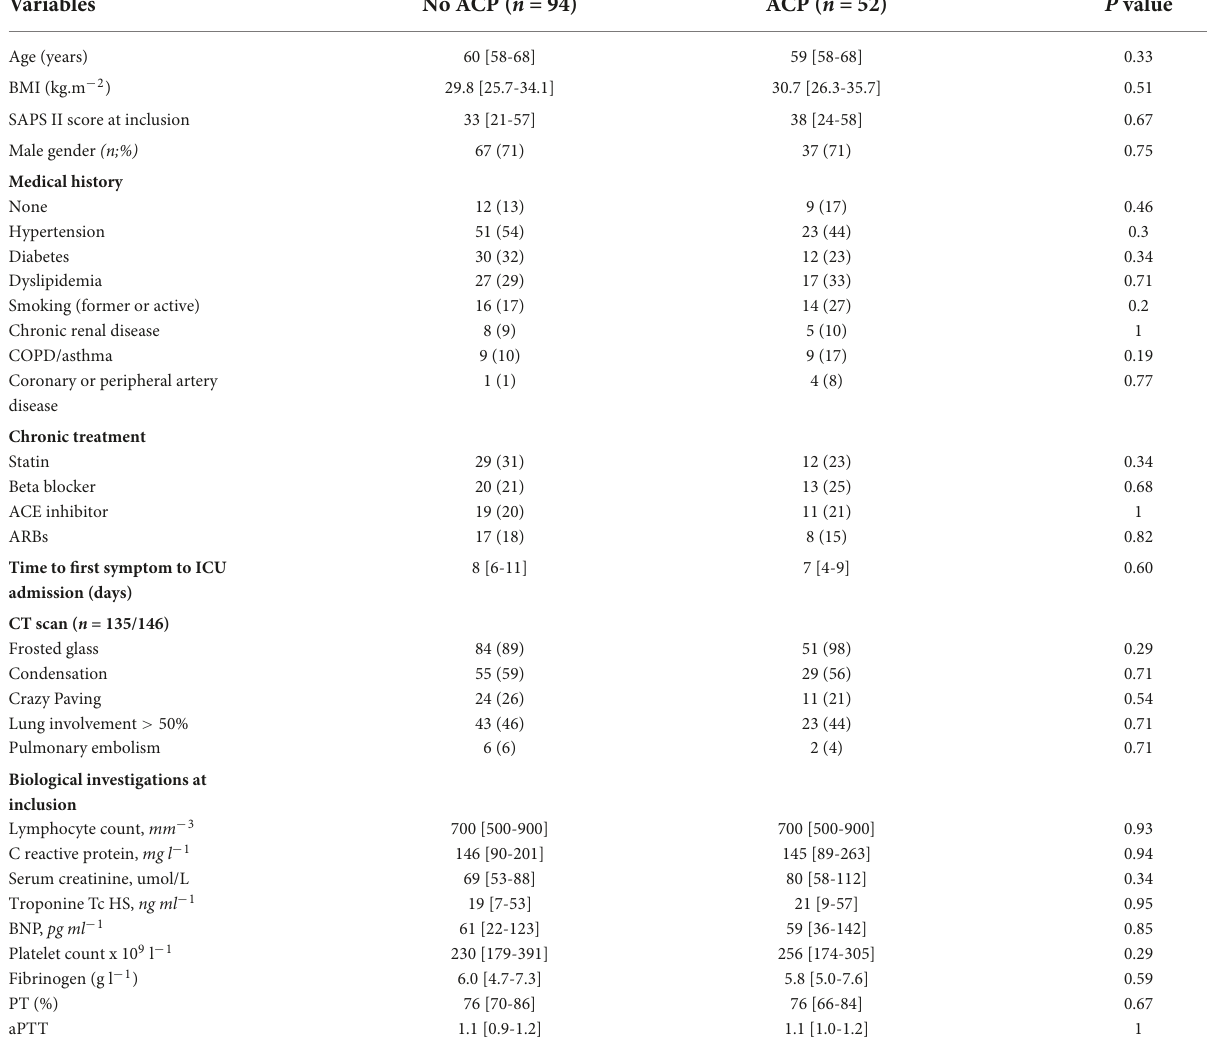
TABLE 1 Demographics and clinical